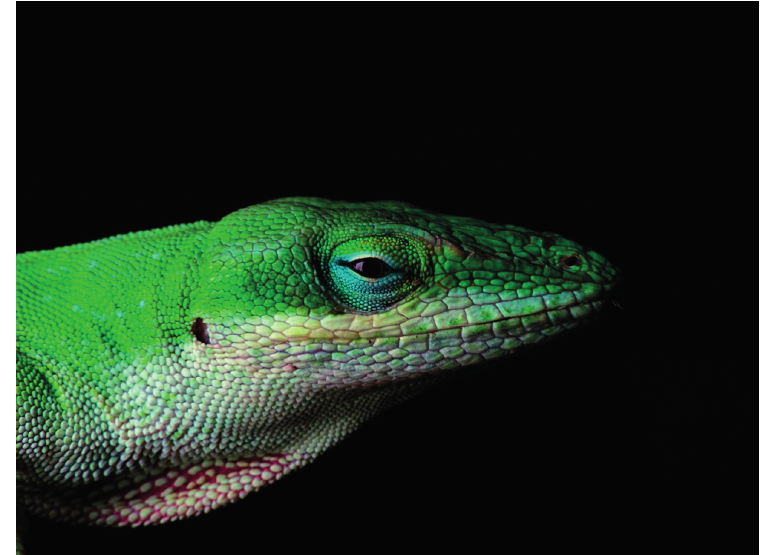
Figure 5. Male Carolina Anole with partially expanded dewlap